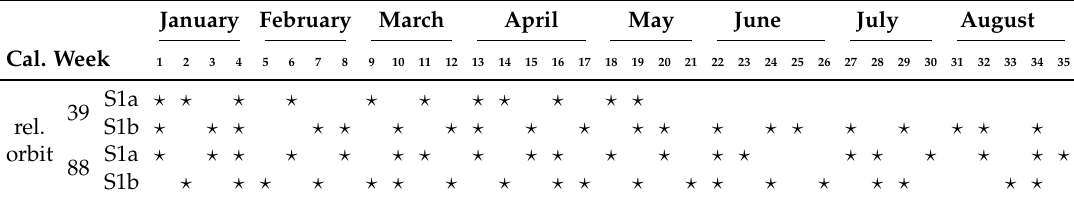
Table 2. Sentinel-1A (S1a) and Sentinel-1b (S1b) acquisitions of the study period, each acquisition covers the whole AOI. As can be seen, there is at least one acquisition for each